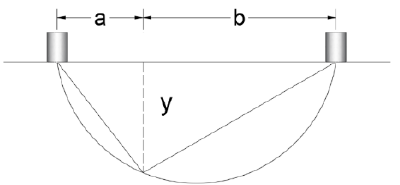
10 of 16 Figure 12. The crack depth measurement process using an ultrasound device.